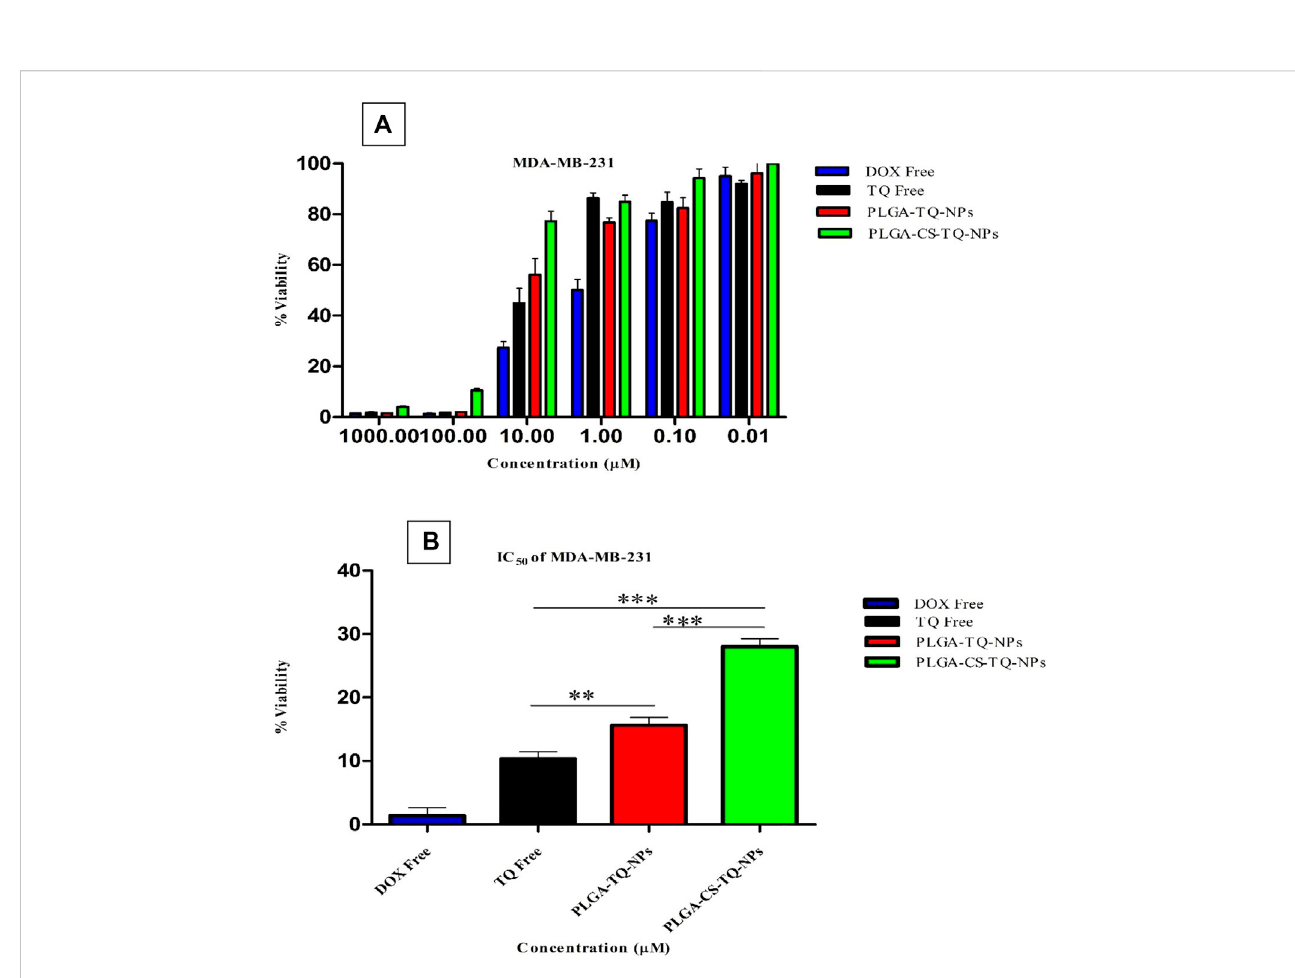
FIGURE 8 (A) Depicts the cell viability of TQ and its nanoformulations on MDA-MB-231 cells. (B) Comparison of inhibition at IC 50 value by TQ and its